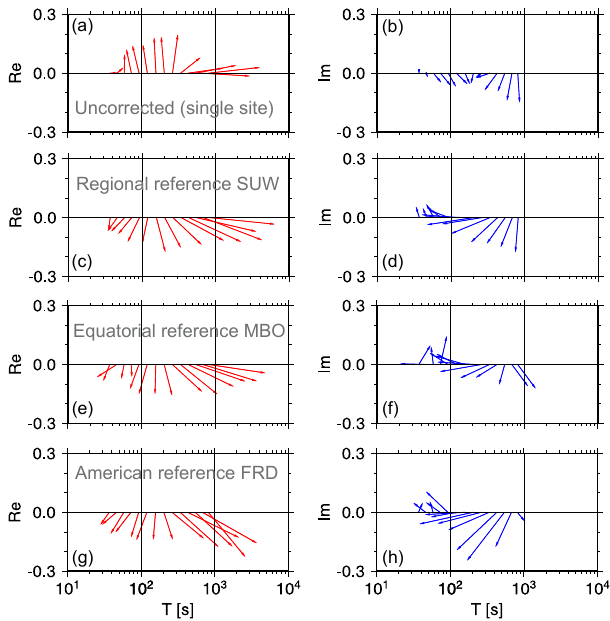
Figure 1. Real (a, c, e, g) and imaginary (b, d, f, h) induction ar- rows for Belsk observatory. The north-pointing real arrows in the single-site processed upper panel are an effect of distortion by DC railway noise. This effect vanishes if data are processed with the re- mote reference method (three lower panels). Very far reference sites (MBO, Senegal, and FRD, US) are similarly helpful to a classical regional one (SUW) if the data amount is sufficiently high (15 days for both upper panels, 101 days with MBO, 85 days with